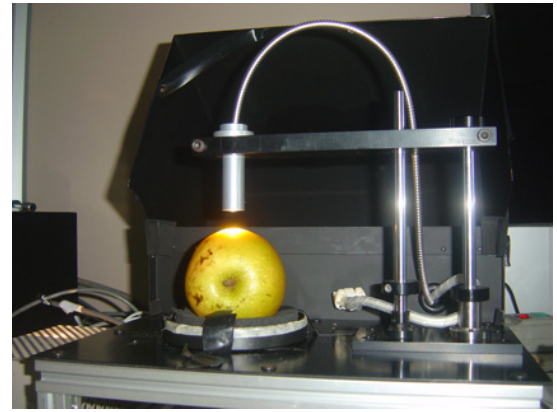
Fig. 2. The measuring position of pear on a PureSpect NIR instrument (Saika TIF, Japan).